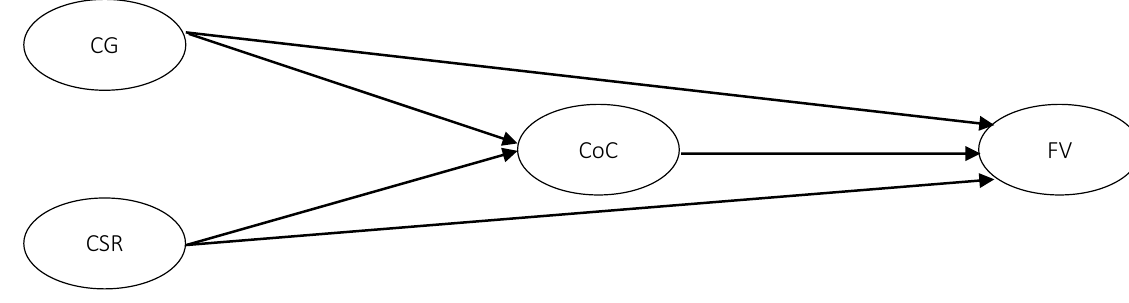
Figure 2. Research